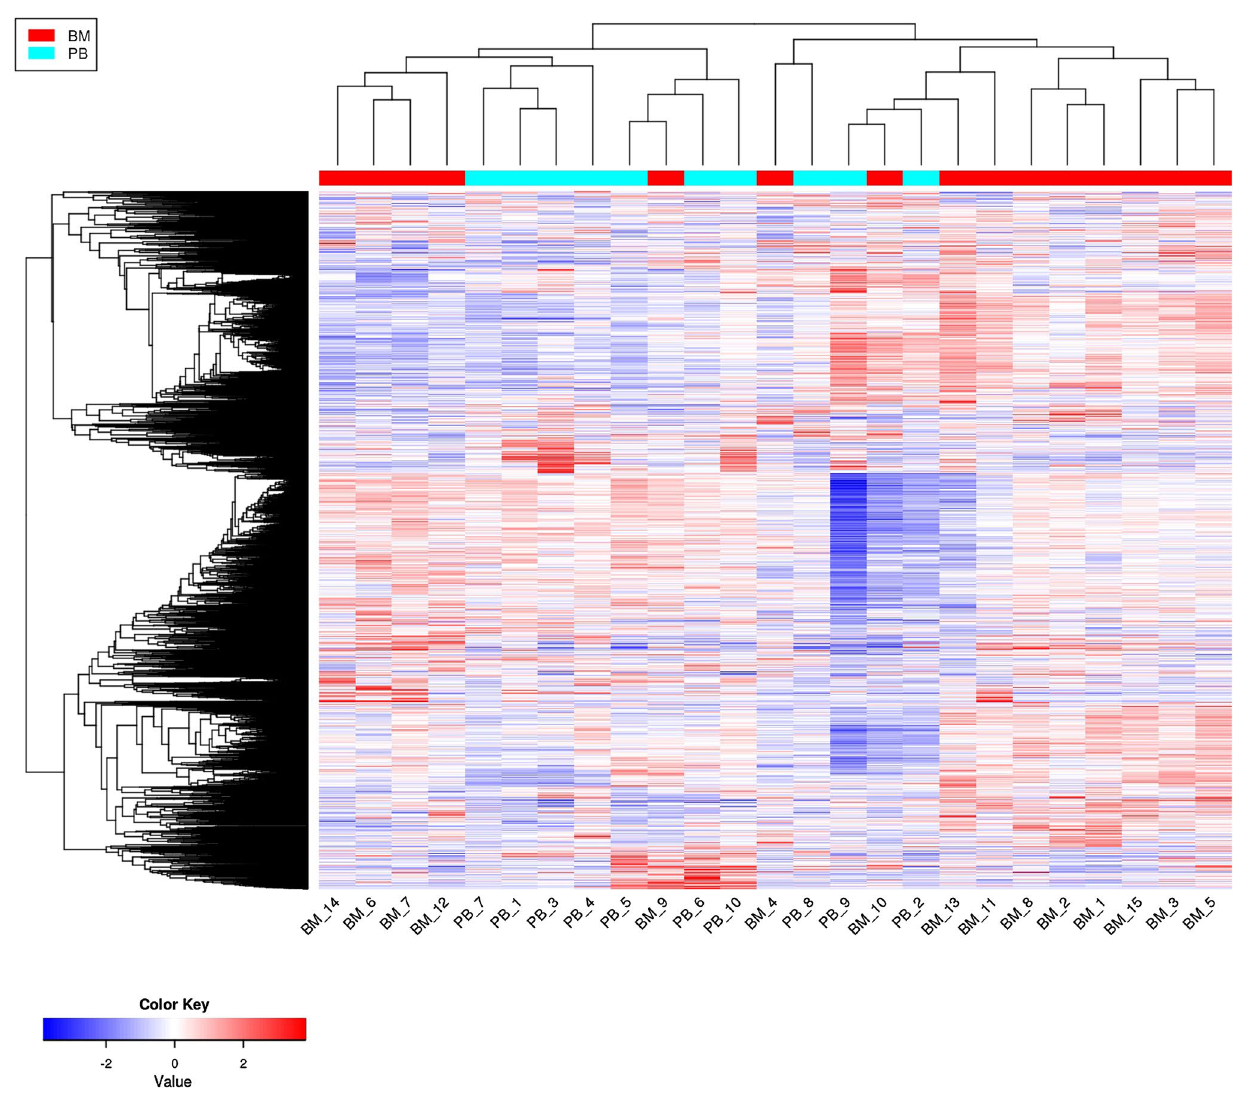
Fig. 7 Correlation heatmap of RNA seq data of the TARGET BM vs. PB